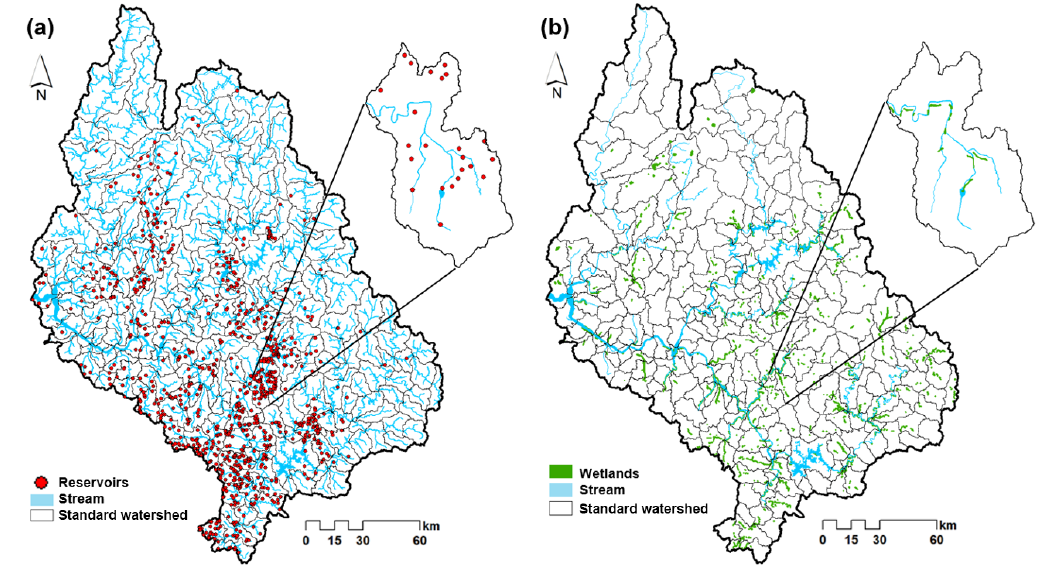
Figure 7. Aquatic habitat conditions for the (a) aquatic habitat connectivity and (b)